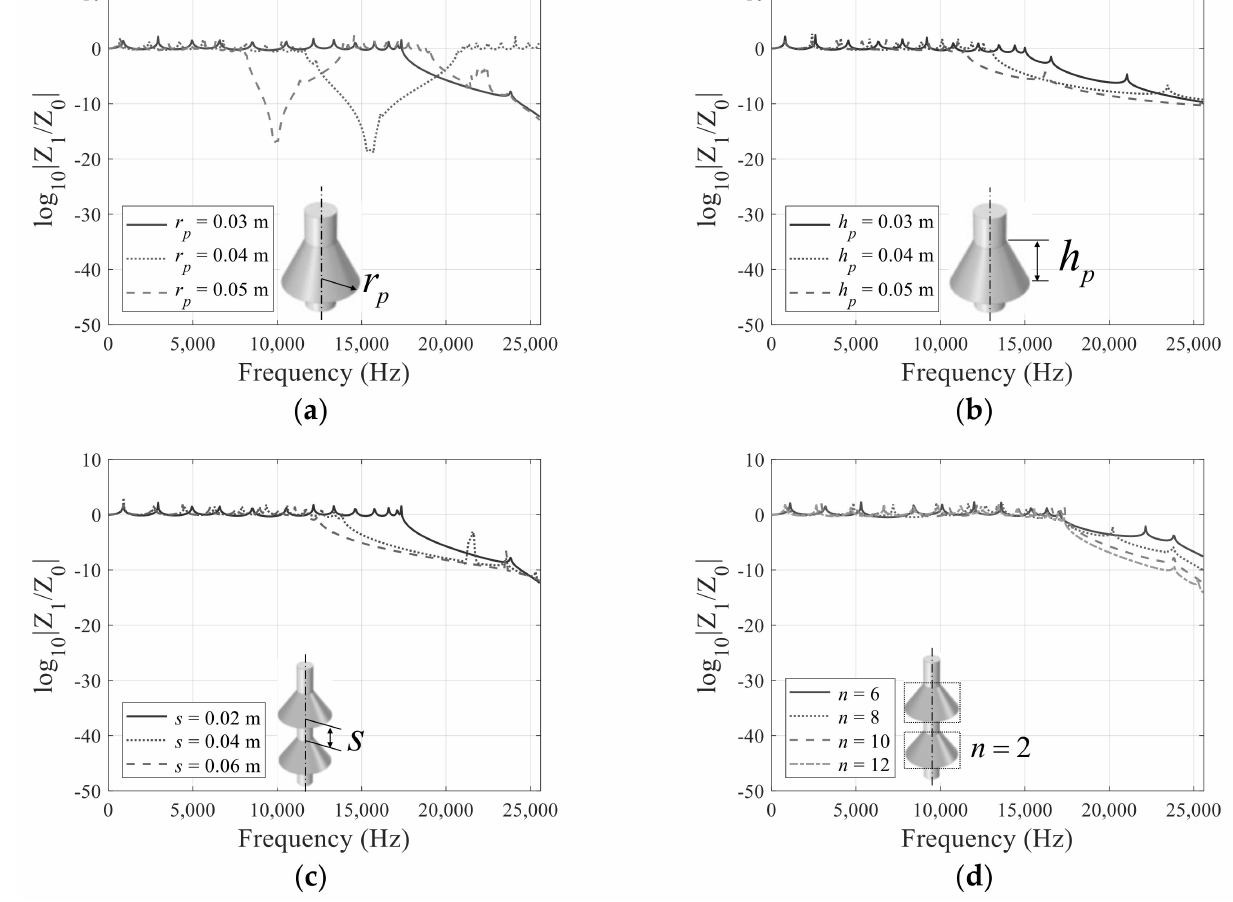
Figure 9. Frequency response analysis results for each parameter of straight beam with repeated conical of the metamaterials for the longitudinal wave: ( a ) h p = 0.02 m, n = 10, d = 0.02 m ( b ) r p = 0.03 m, n = 10, d = 0.02 m ( c ) r p = 0.03 m, h p = 0.02 m n = 10 ( d ) r p = 0.03 m, h p = 0.02 m d = 0.02